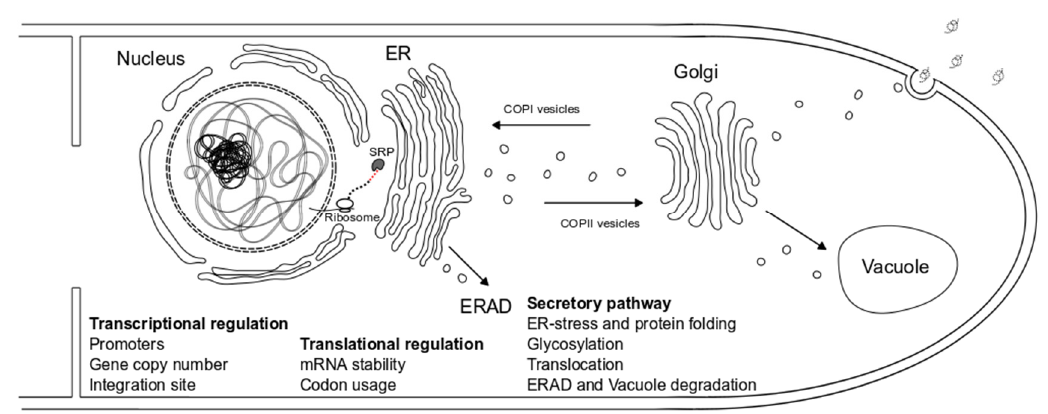
Figure 1. Protein synthesis and secretion in a fungal (e.g., A. niger ) cell are schematically described. The figure also presents key steps that can be bottlenecks in the production of recombinant proteins